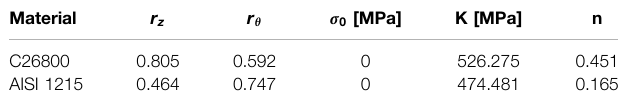
TABLE 1 | Mechanical properties of C26800 and AISI 1215.